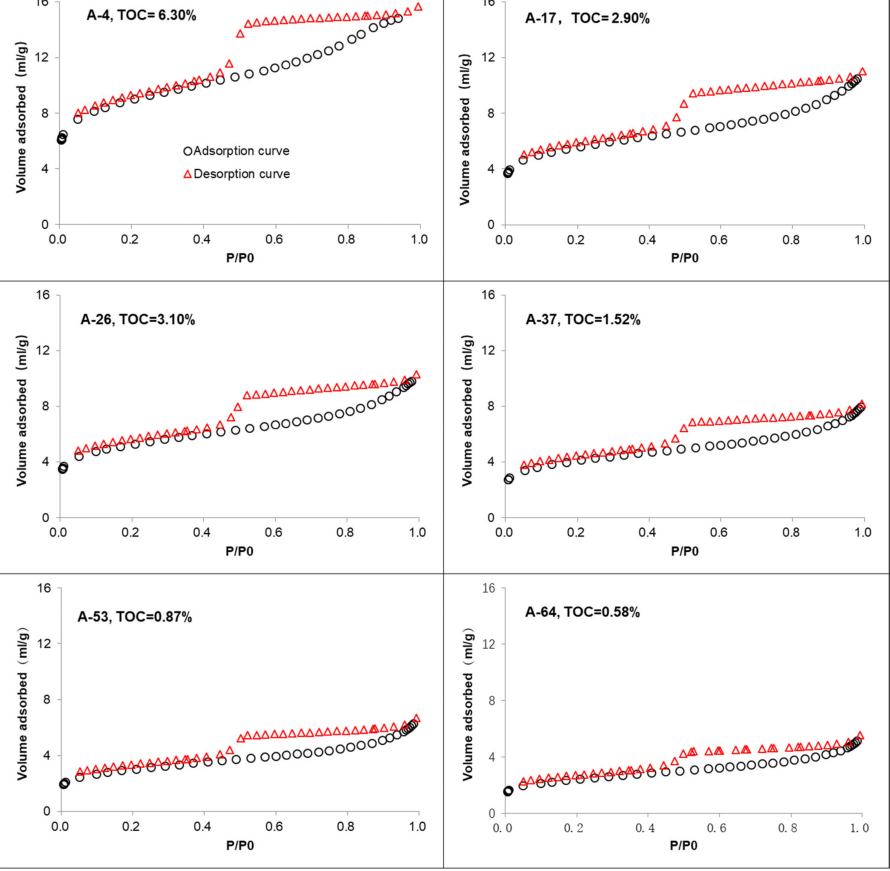
Figure 7. Nitrogen adsorption-desorption isotherms for samples from Well A in the Dingshan area of Sichuan Basin, showing similar type and the volume adsorbed decreased with TOC